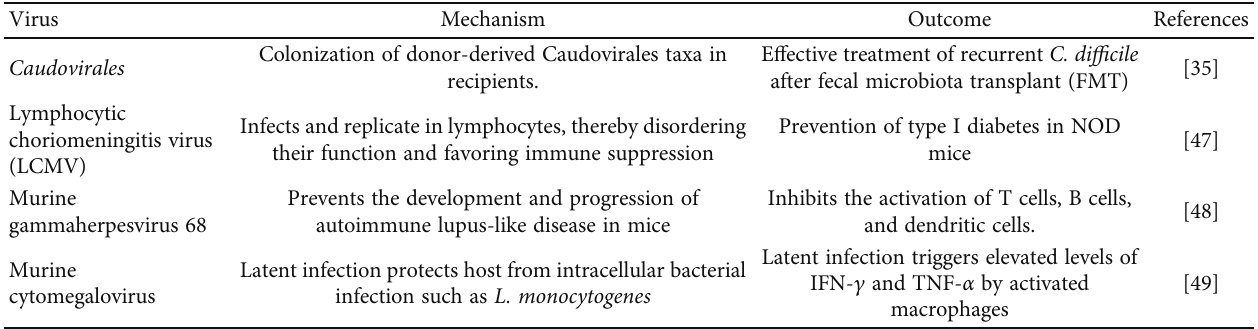
Figure 2: Figure illustrates the two main compositions of the human intestinal virome (bacteriophages and eukaryotic viruses). The bacteriophages present the most abundant and can be subdivided into lytic and lysogenic phages depending on the infection outcome in bacteria. Table 2: Examples of intestinal viruses and their role in maintaining gut